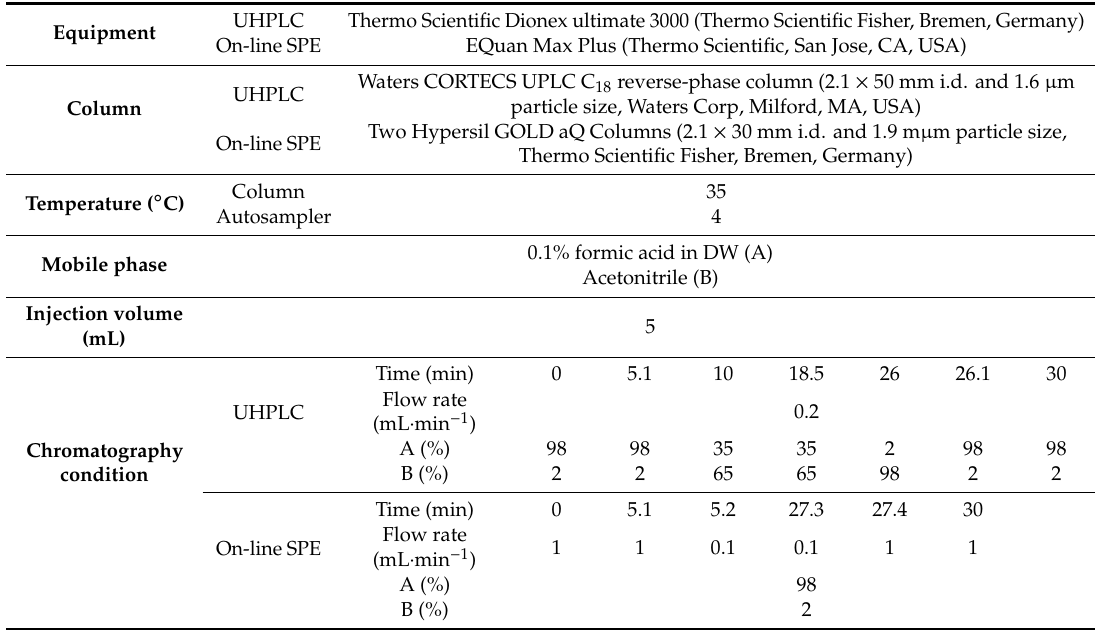
Table 3. Analysis condition for selected target chemicals. UHPLC—ultra-high-performance liquid chromatography; SPE—solid-phase extraction; DW—distilled